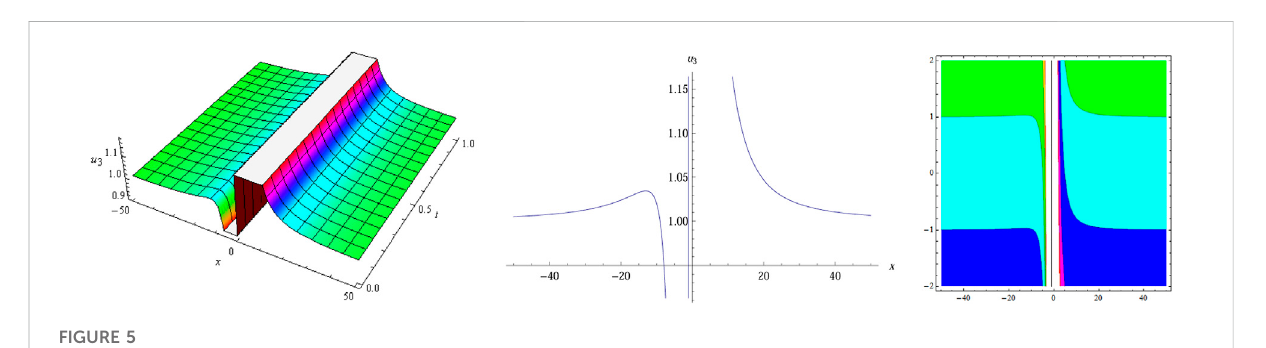
FIGURE 5 3D plot, 2D plot, and contour plot of u 3 with α (cid:2) β (cid:2)